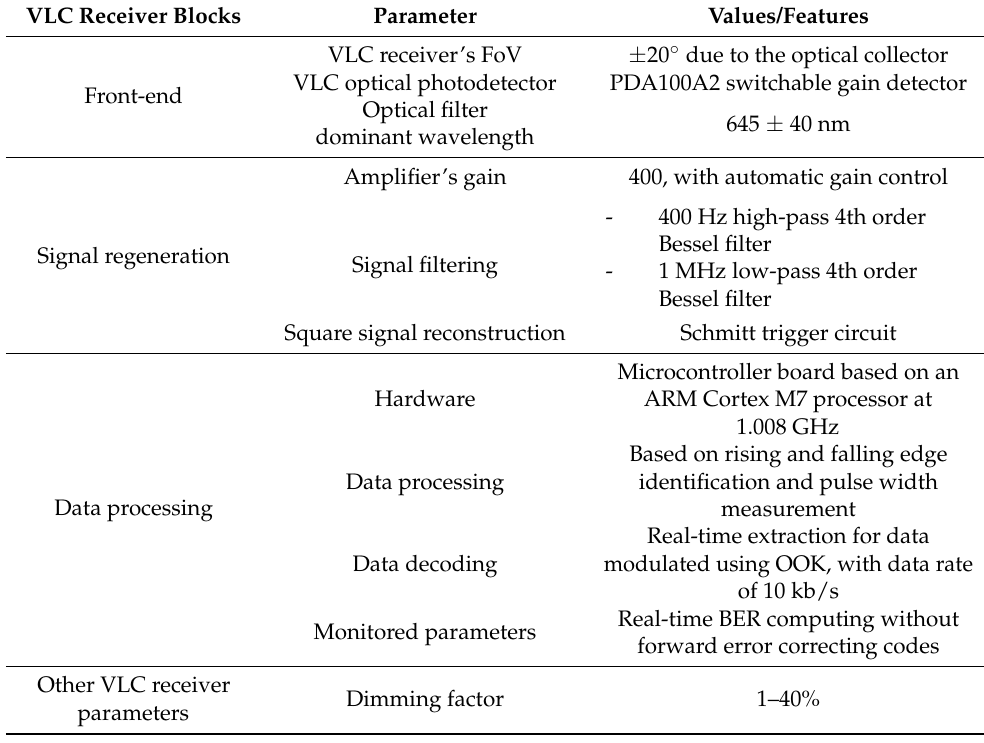
Table 3. Parameters of the VLC receiver test